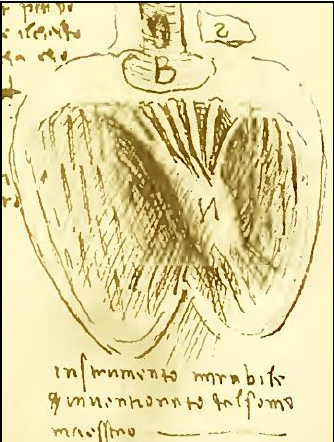
Figure 1. “ Instrumento mirabile invenzionato dal sommo maestro ”, Leonardo da Vinci, Dell’Anatomia, 1489, Fogli B, readable mirror image of Figure 64, foglio 12, recto; public domain electronic copy at: https://archive.org/stream/imanoscrittidile00leon#page/2.